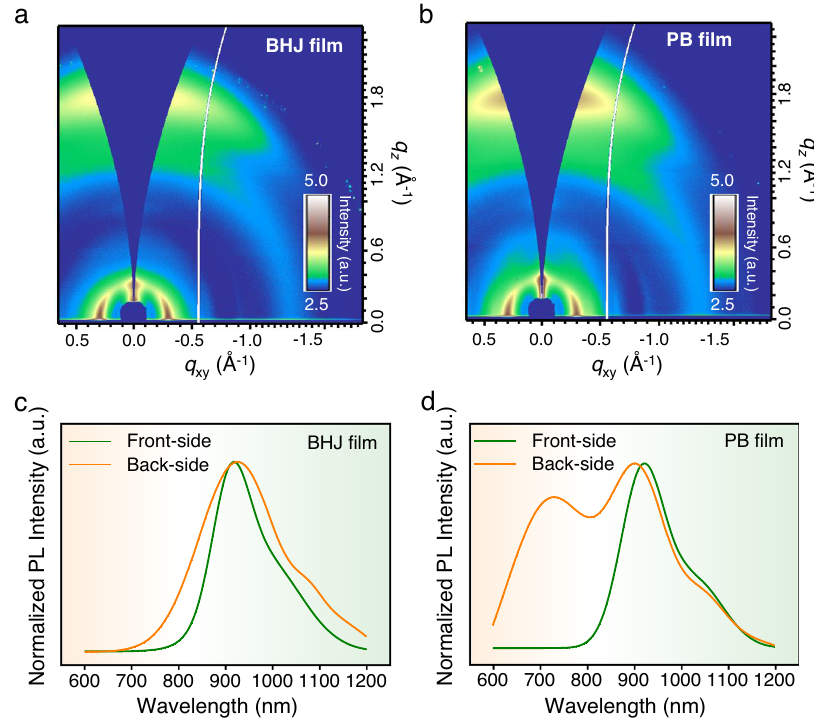
Fig. 2 Morphological characterization for fi lms with BHJ and PB architectures. a, b 2D GIWAXS patterns of PM6:N3:PC 71 BM blend fi lm with a BHJ and b PB architectures. c , d The PL spectra of the fi lms with c BHJ and d PB architectures, which were excited from the front- and